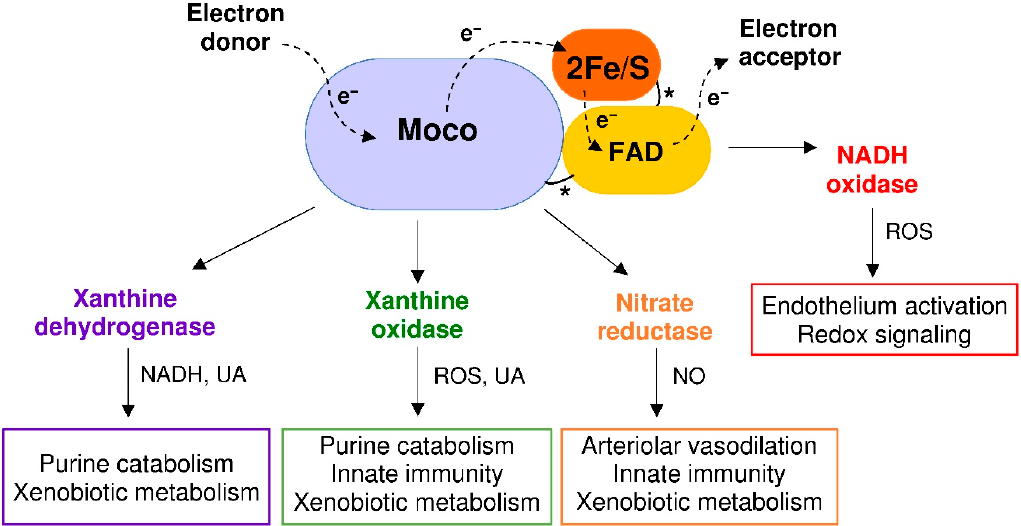
Figure 2. Xanthine oxidoreductase (XOR) structure and activities. Each XOR subunit is composed of three domains connected by unstructured regions (*) and characterized by: (i) two iron-sulfur redox centers (2Fe / S), (ii) a flavin adenine dinucleotide (FAD) cofactor and (iii) a molybdenum containing molybdopterin cofactor (Moco). The dotted arrows show the electron (e − ) flux direction. The products and functions of each XOR activity are indicated: reduced nicotinamide adenine dinucleotide (NADH); nitric oxide (NO); reactive oxygen species (ROS); and uric acid (UA).